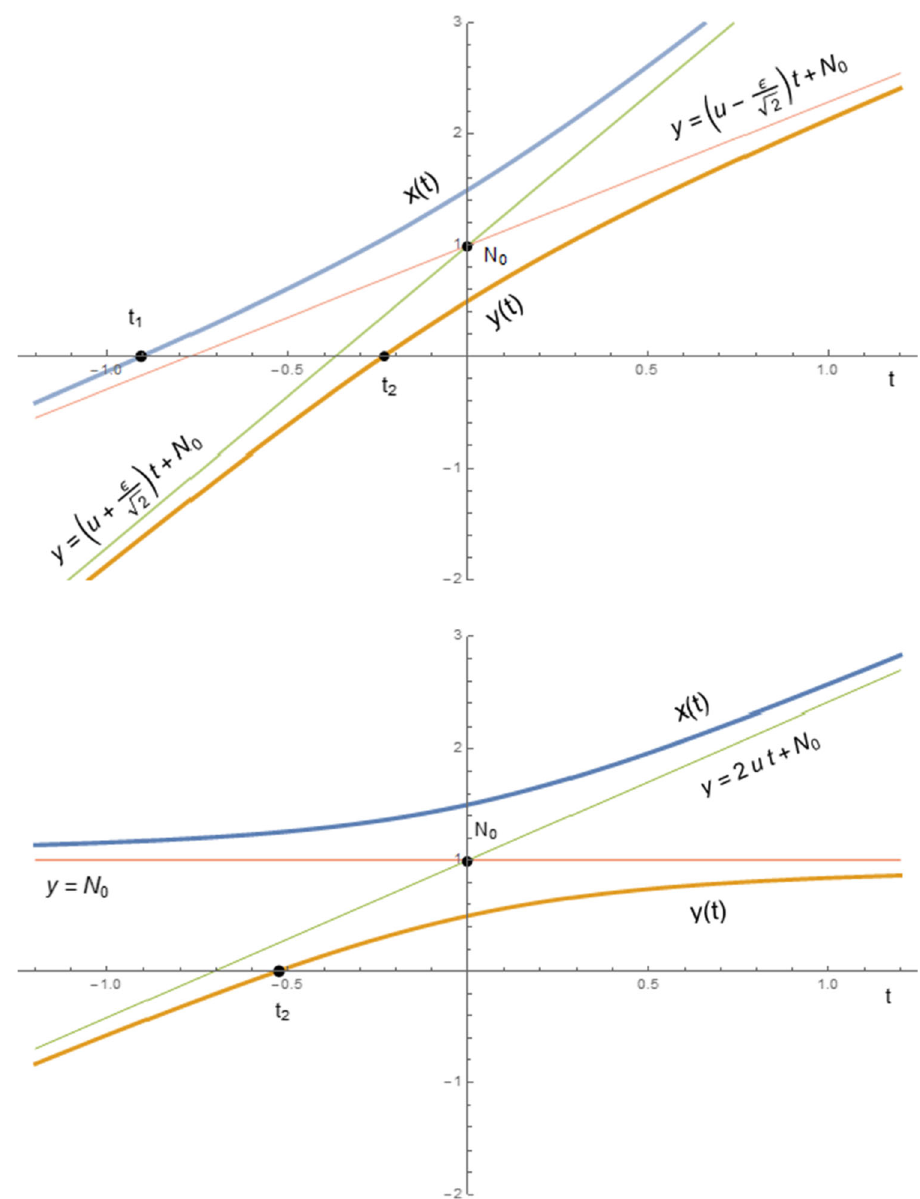
Fig. 1 Evolution of the scale factors of two interacting universes. Case u >